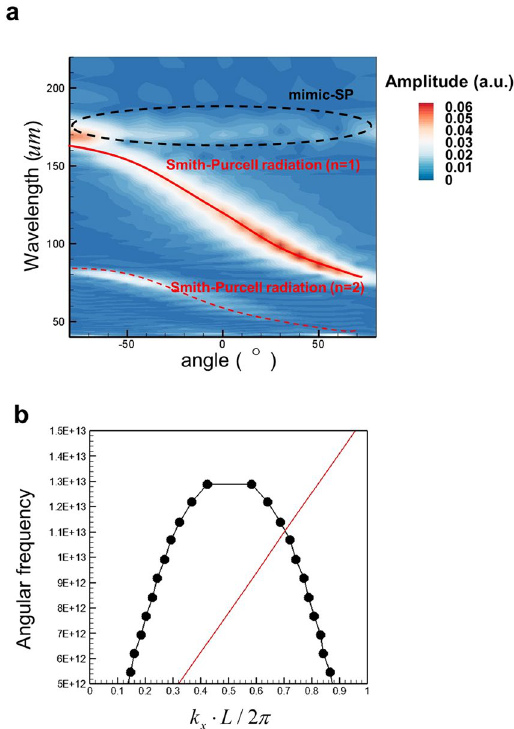
Figure 3. Simulated results for an electron bunch passing over a PEC grating. ( a ) Simulated contours of Fourier spectra of Hz fields as functions of emission wavelength and angle at the observation points. Red solid and dashed lines: wavelength-angle relation of traditional SPR for n = 1 and 2, respectively. ( b ) Dispersive curves of mimic-SP (black line) and electron bunch (red line). E = 40 keV and h = 22.5 u